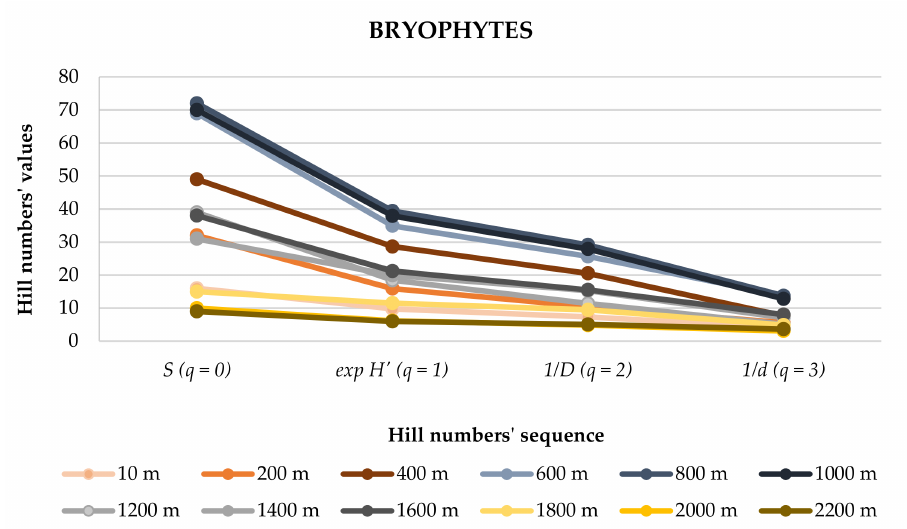
Figure 4. Diversity (Hill numbers) profile for the bryophytes of the different elevational bands in the Pico Island transect.